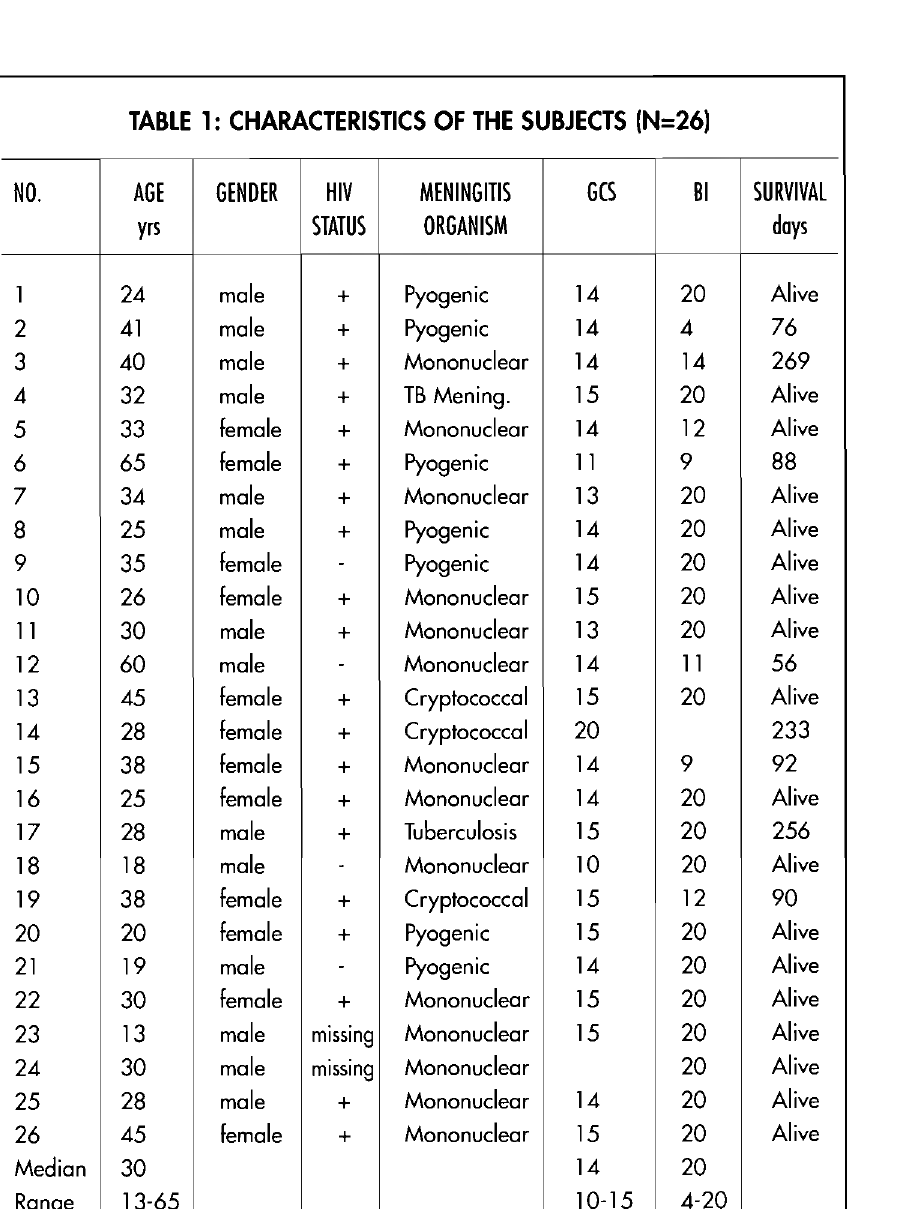
TABLE 1: CHARACTERISTICS OF THE SUBJECTS